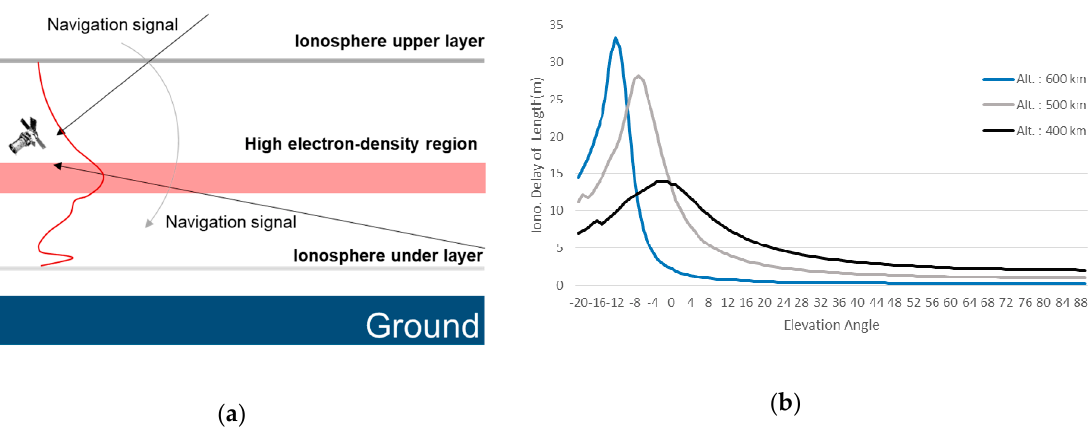
Figure 4. Features of ionospheric time delay affecting pseudo-range according to the incidence angle of the navigation signal [14]. ( a ) The practical tendency of ionospheric time delay can be summarized as being likely to receive the navigation signal from a negative incidence angle. ( b ) Peaks of time delays.